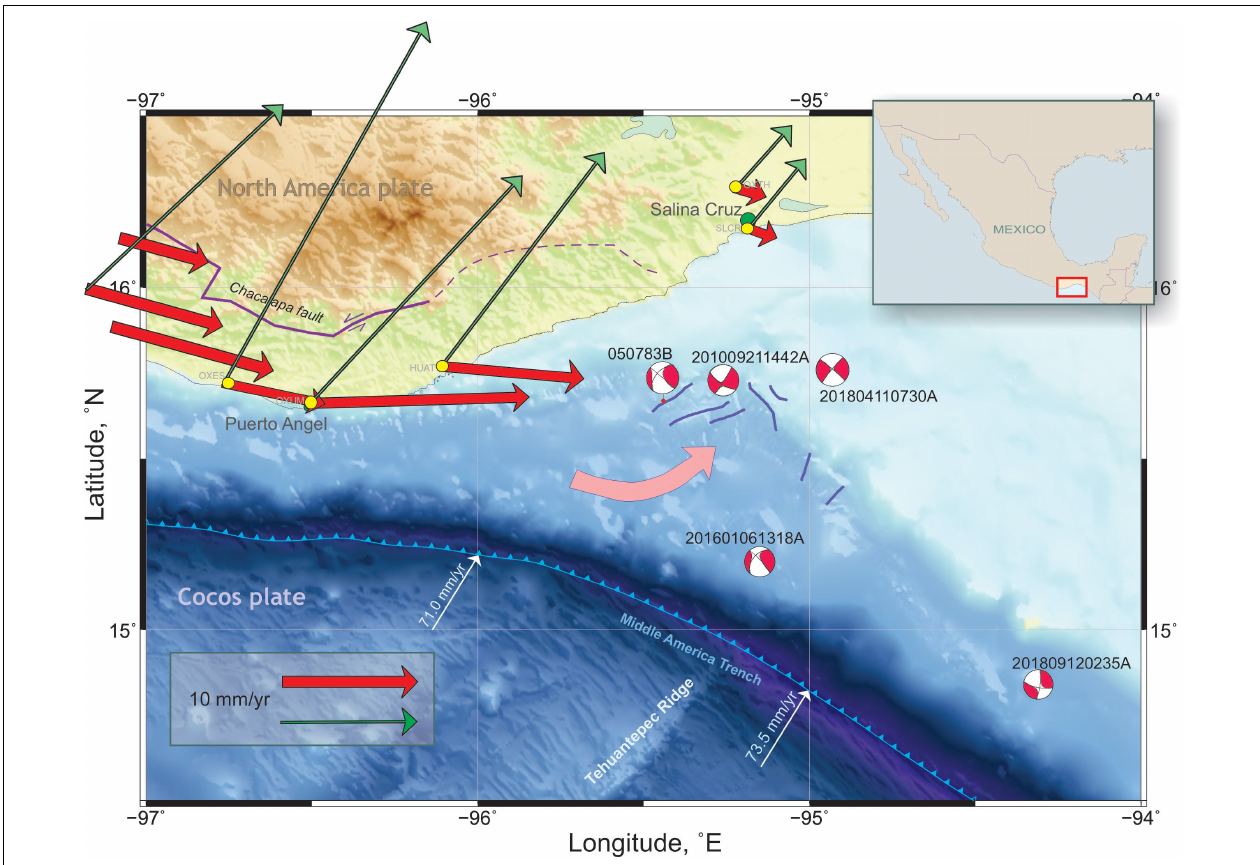
FIGURE 9 | Detailed map of the subduction zone in the region of the Tehuantepec ridge. The inset shows a location of this area. Red vectors are secular sinistral GPS velocities (the same as in Figure 8 ). The only crustal strike-slip events in the Global CMT catalog are shown as red beach balls with their catalog codes. Blue lines offshore, south of Salina Cruz city are conceivably active faults (Roman-Reinoso,